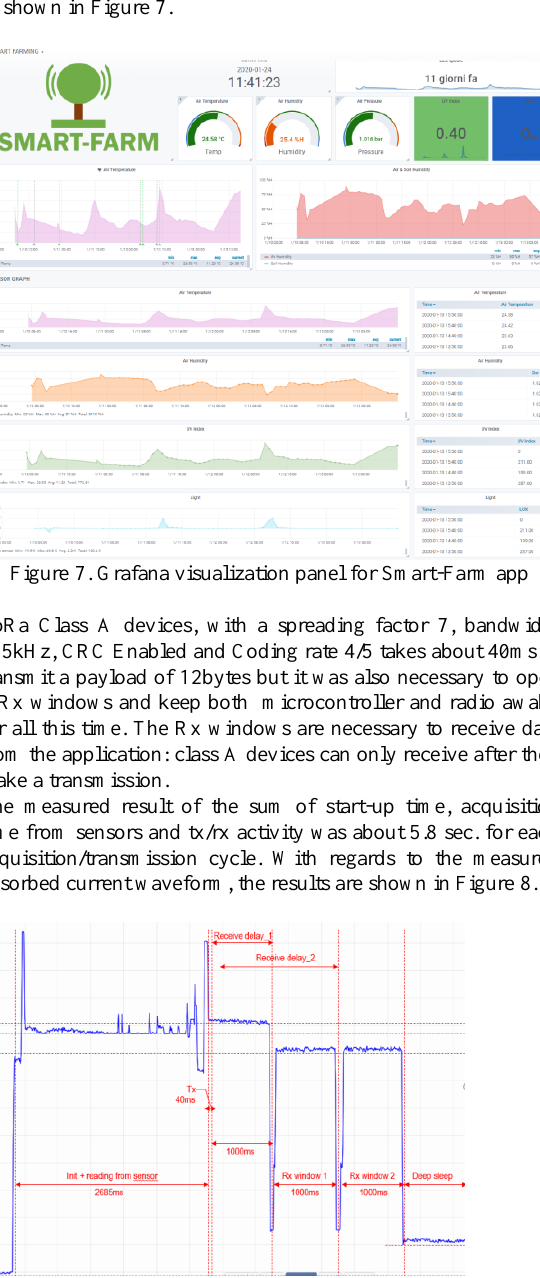
Figure 8. Absorbed current from LoRaWAN sensor device